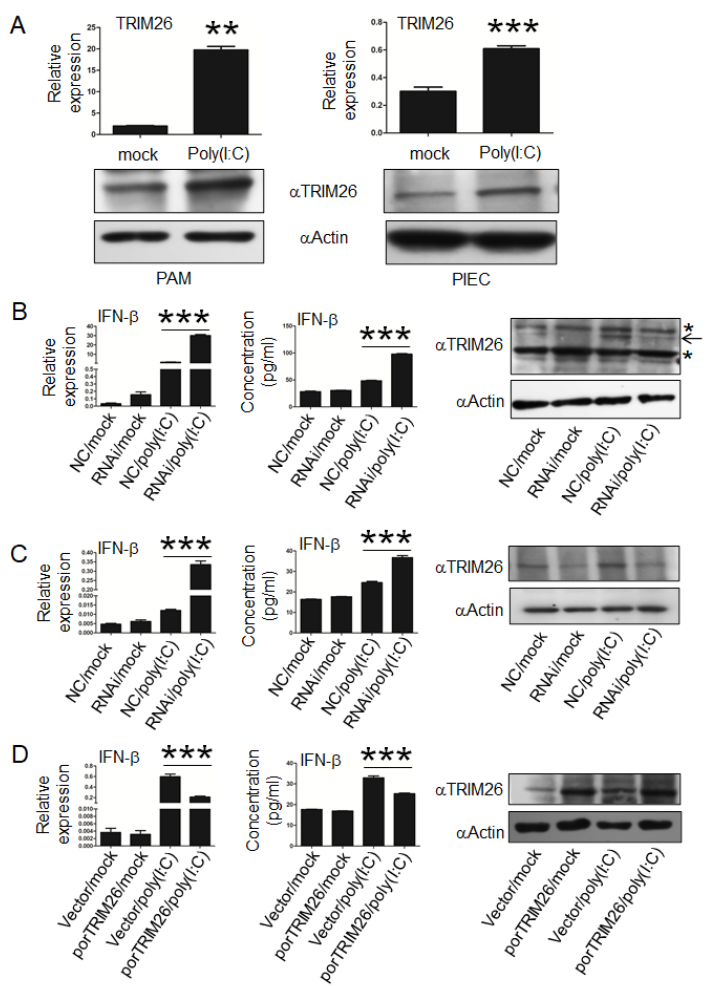
Figure 3. Effect of porTRIM26 on poly (I:C)-induced interferon (IFN)- β . ( A ) Expression of TRIM26 in porcine alveolar macrophages (PAM) or porcine iliac artery endothelial cells (PIEC) with or without poly(I:C) treatment was measured with qPCR and Western blotting. Poly (I:C) treatment induced the expression of TRIM26 in both PAM and PIEC cells. ( B ) PAM were transfected with porTRIM26 siRNA or negative control (NC) siRNA for 72 h and then stimulated with poly (I:C) for 6 h. Supernatant and cells were harvested and analyzed by enzyme-linked immunosorbent assay (ELISA) and qPCR, respectively. ( C ) PIEC cells were transfected with porTRIM26 siRNA or NC siRNA for 72 h, and then stimulated with poly (I:C) for 6 h. Supernatant and cells were harvested and analyzed by ELISA and qPCR, respectively. ( D ) PIEC cells were transfected with plasmid encoding porTRIM26 or the empty vector. After 24 h, the cells were treated with poly (I · C) or vehicle and incubated for another 6 h. Level of IFN- β mRNA was determined with RT-qPCR. Data present are mean ± SEM pooled from one independent experiment; n ≥ 3 for each of the analyzed parameters. *, p < 0.05; **, p < 0.01; ***, p < 0.001 in comparison between mock and poly (I:C) group ( A ); between NC and RNAi with poly (I:C) stimulation ( B , C ); and between the empty vector and pFlag-porTRIM26 with poly (I:C) stimulation ( D ).